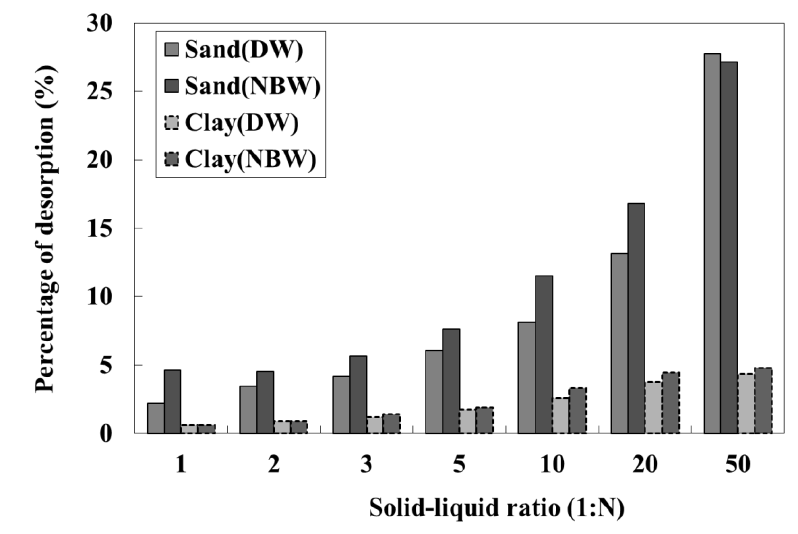
Figure 5. Solid-liquid ration test.